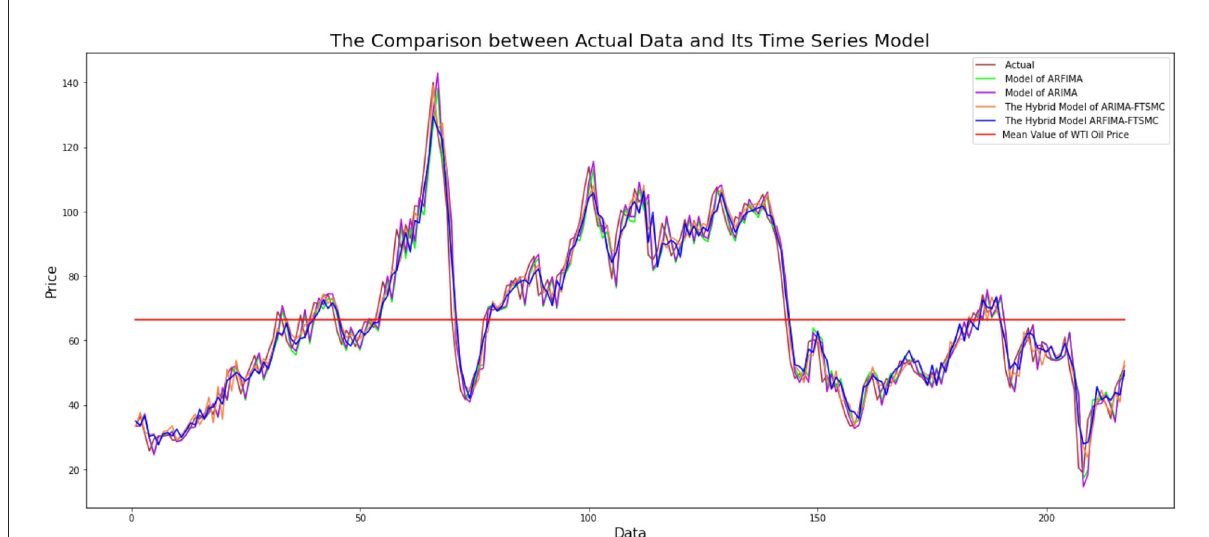
FIGURE6 Comparison graph of actual data with ARIMA, ARFIMA, hybrid ARIMA-FTSMC, and hybrid ARFIMA-FTSMC models.